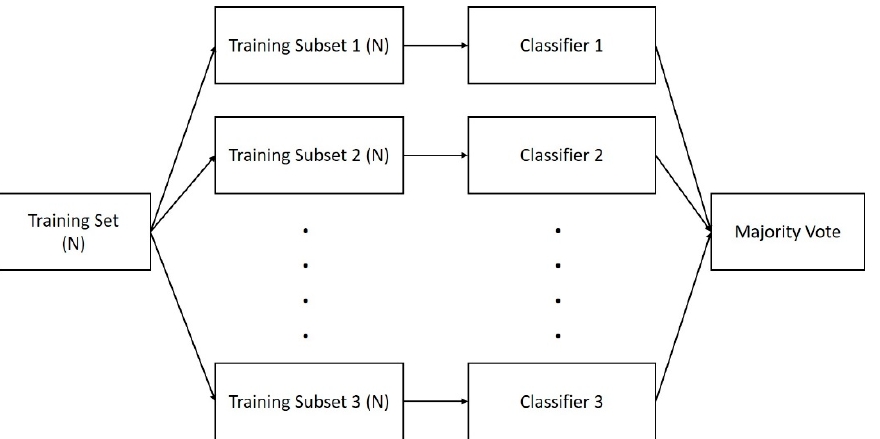
Figure 2. Bagging diagram of an integrated algorithm.